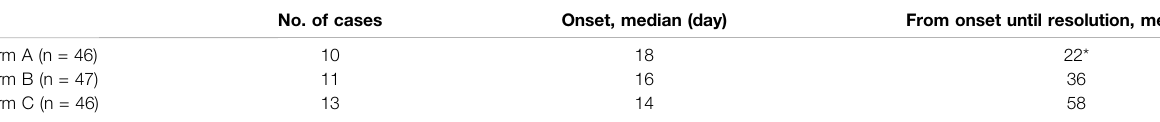
TABLE 4 | Incidence and grading of acneiform rash with pruritus.